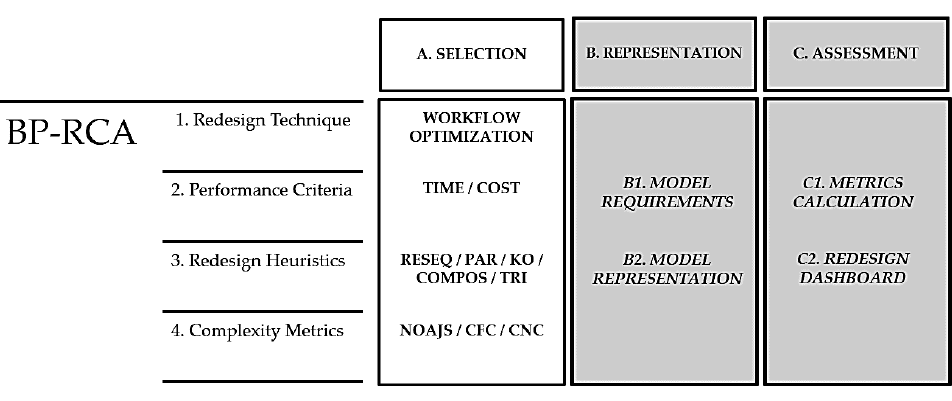
Figure 5. An overview of indicative redesign choices in the BP-RCA Selection Phase .